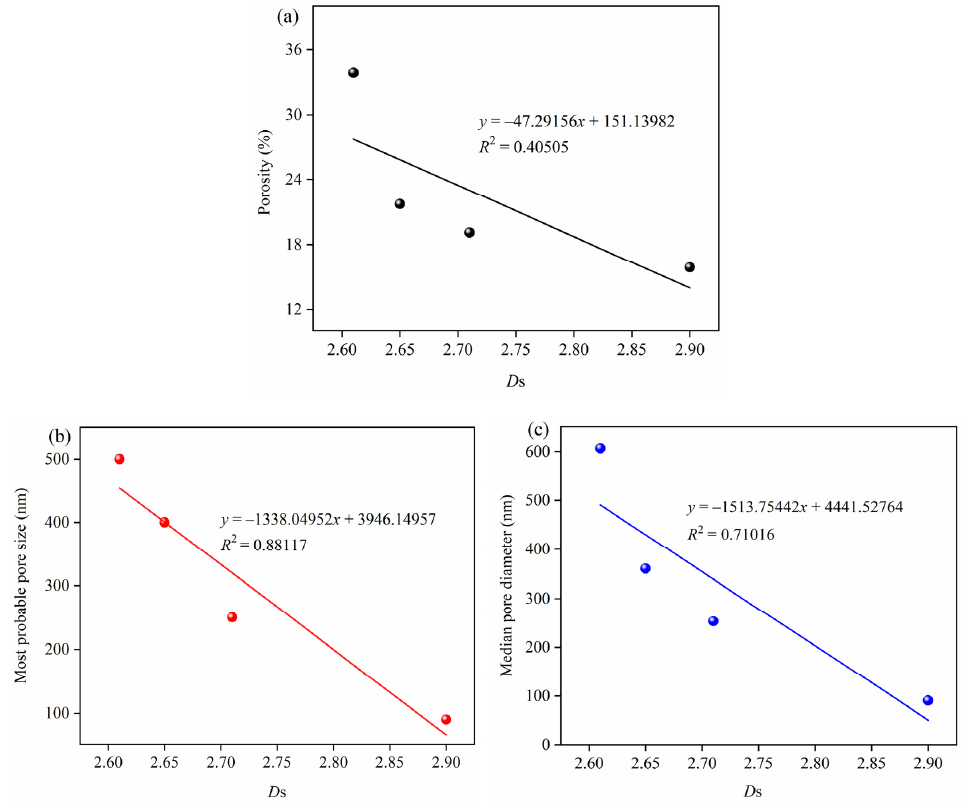
Figure 11. Relationship between D s and ( a ) porosity, ( b ) most probable pore size, and ( c ) median pore diameter of porous alumina.